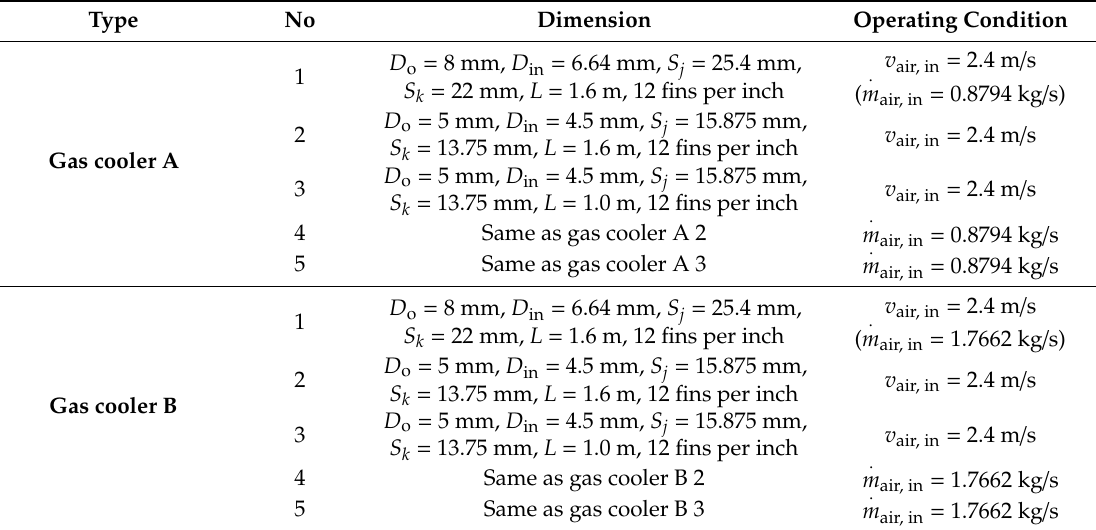
Table 2. Geometry and operating conditions for comparison between 8 mm and 5 mm coils finned-tube gas coolers.